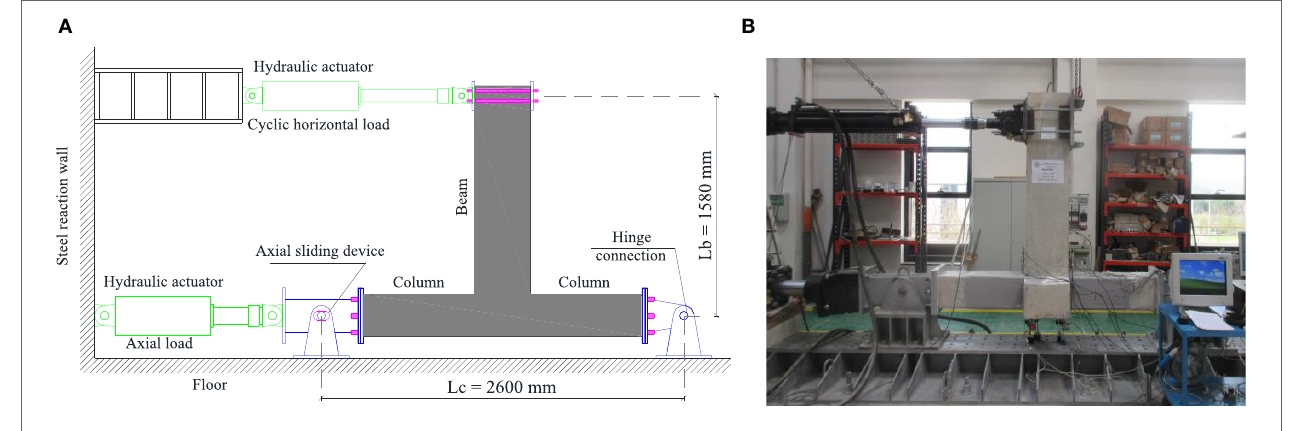
FIGURE 5 | Test setup: schematic (A) , and photo taken in the laboratory (B) . ∆ y ( (cid:25) 14 mm); two different displacement rates were considered during the tests: 0.2 mm/s before the achievement of ∆ y and 1 mm/s after ∆ y